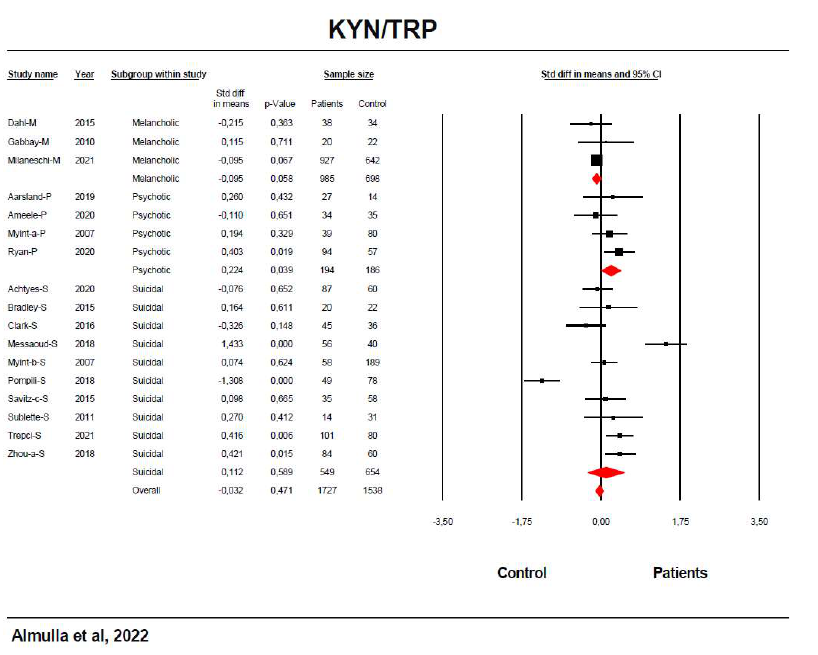
Figure 4. The forest plot of kynurenine (KYN)/tryptophan (TRP) ratio between severe affective disorder patients and healthy control.